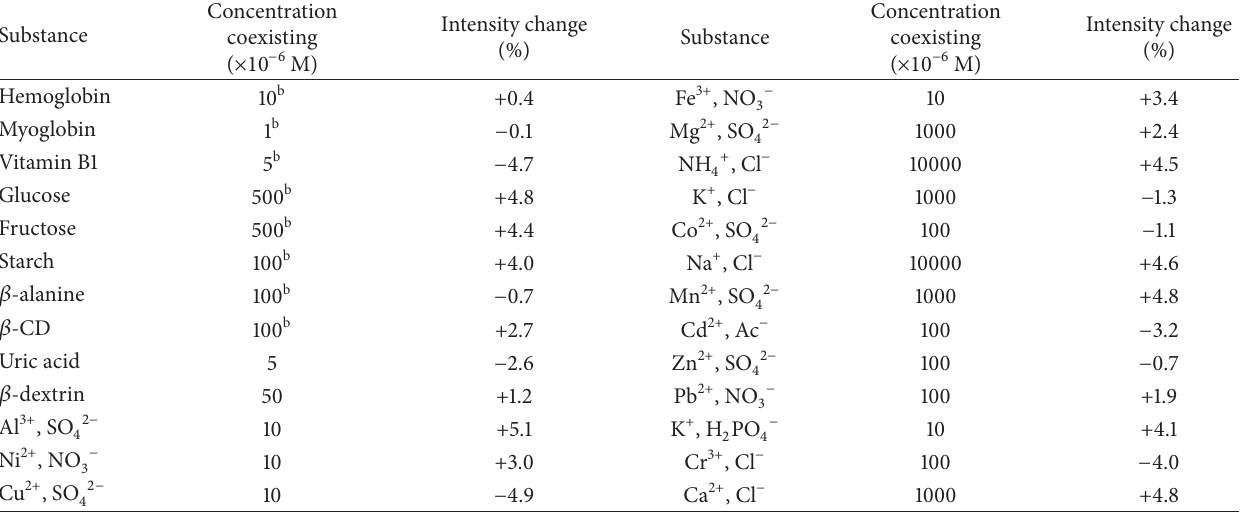
Figure 6: Absorption spectrum of Tb(III) (1) and emission spectra of PFLX (2) and OFLX (3) Conditions: Tb(III), 2.0 × 10 −4 M; PFLX and OFLX, 1.0 × 10 −6 M. Table 1: Tolerance of coexisting substance a .